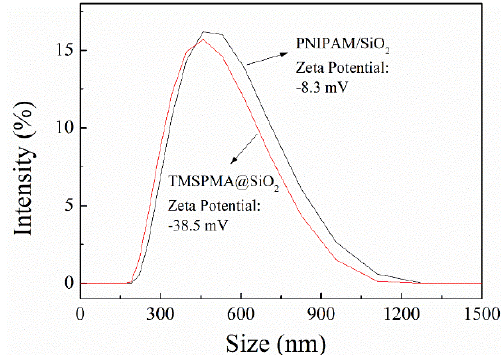
Figure 4. Particle size distribution curves of TMSPMA@SiO 2 and PNIPAM/SiO 2 particles (pH = 7, T = 25 °C).